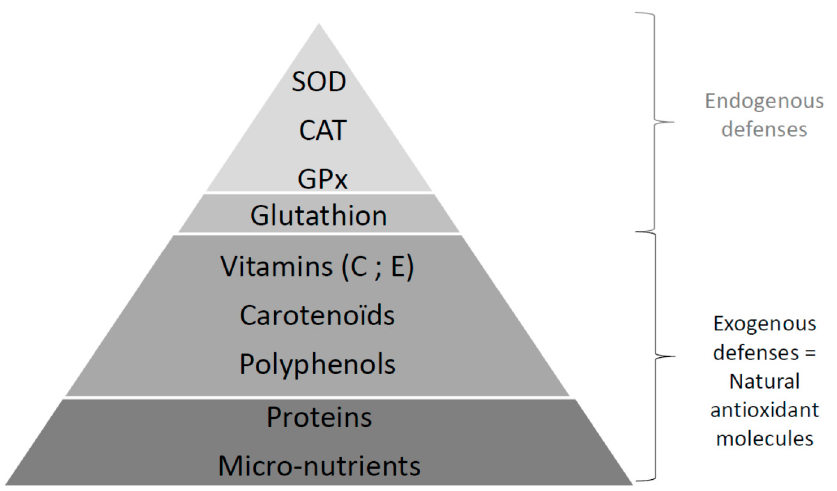
Figure 3. Oxidative defense strategies. CAT: catalase; GPx: glutathione peroxydase; SOD: superoxyde dismutases.